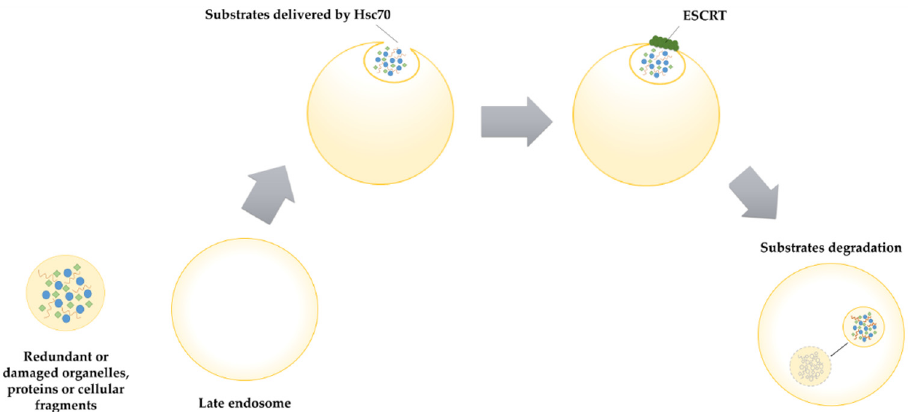
Figure 3. Microautophagy. Redundant or damaged organelles, proteins or cellular fragments are transported inside the formed vesicle to the late endosome by Hsc70. Subsequently, endosomal membrane invagination occurs with the involvement of ESCRT (Endosomal Sorting Complex Required for Transport). The final stage of microautophagy process is the degradation of substrates inside the endosome.